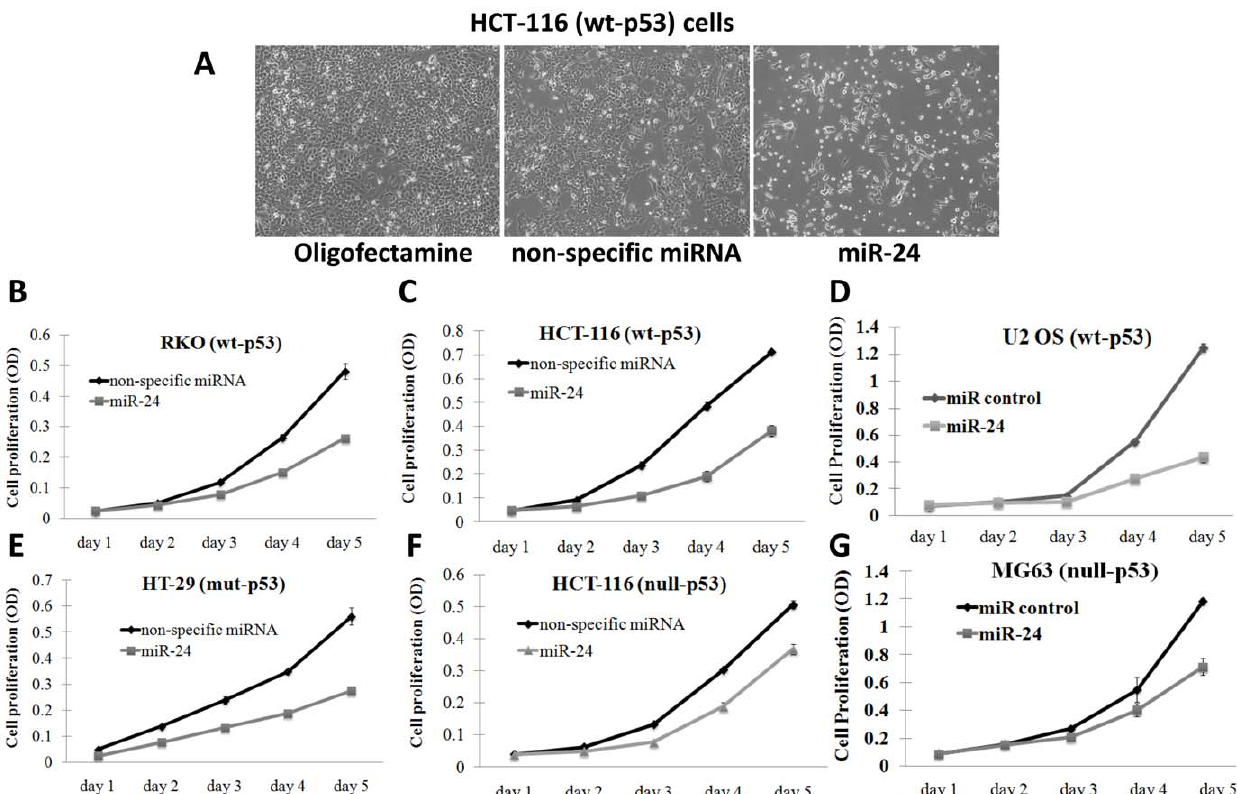
Figure 1. MiR-24 inhibits anchorage-dependent cell proliferation independent of p53 status in six different cancer cell lines. (A) Morphological changes after the non-specific control-miR and miR-24 over expression in HCT-116 (wt-p53) is demonstrated. (B–G) Six different cancer cell lines, with or without functional p53, were transfected with control miR (neg) or miR-24 and cell number was determined. Upon miR-24 transfection cell proliferation was inhibited approximately from 30% to 65% at day 5 as compared to the control (p , 0.05, standard deviations are plotted as error bars on the graphs). Of interest, regardless of the p53 status of a cell, miR-24 inhibited cell proliferation.